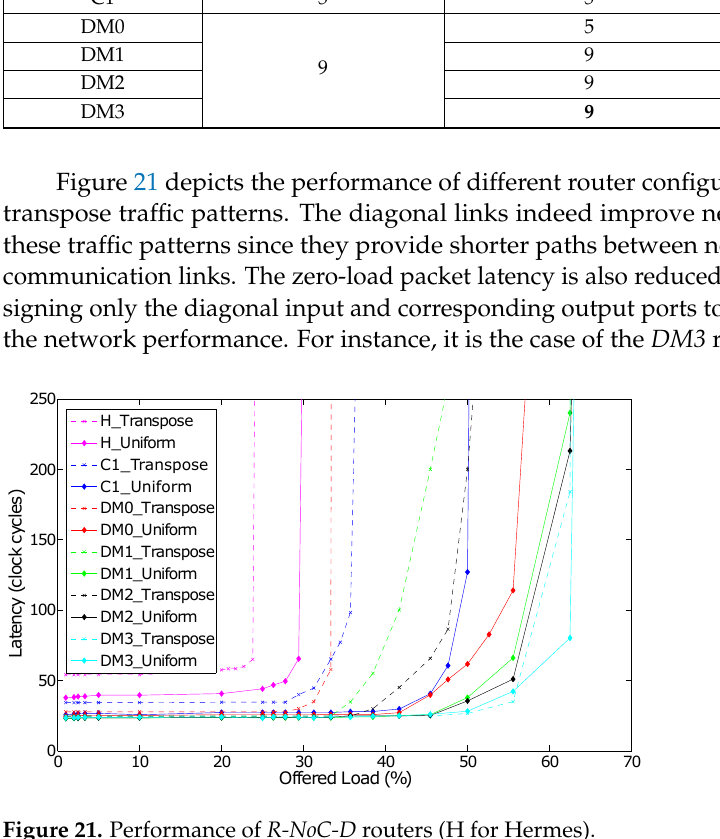
Figure 21. Performance of R-NoC-D routers (H for